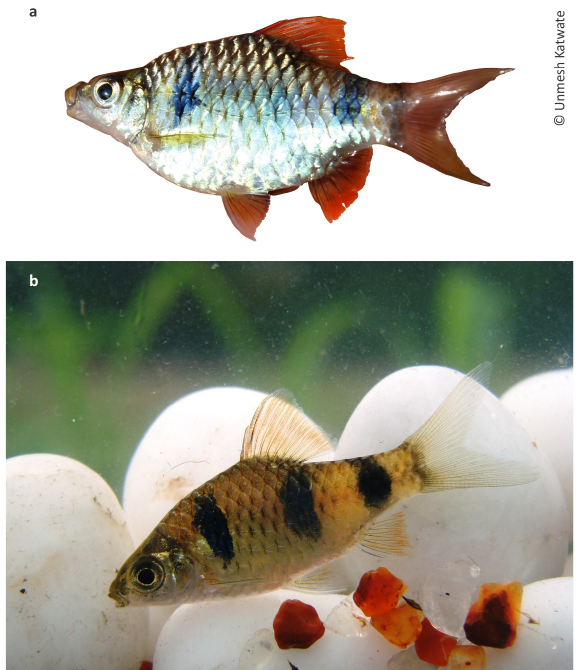
Image 4. Pethia setnai showing color in life. (a) fresh specimen from Sanguem, Goa; and (b) live specimen from Terekhol River near Madkhol, Maharashtra.